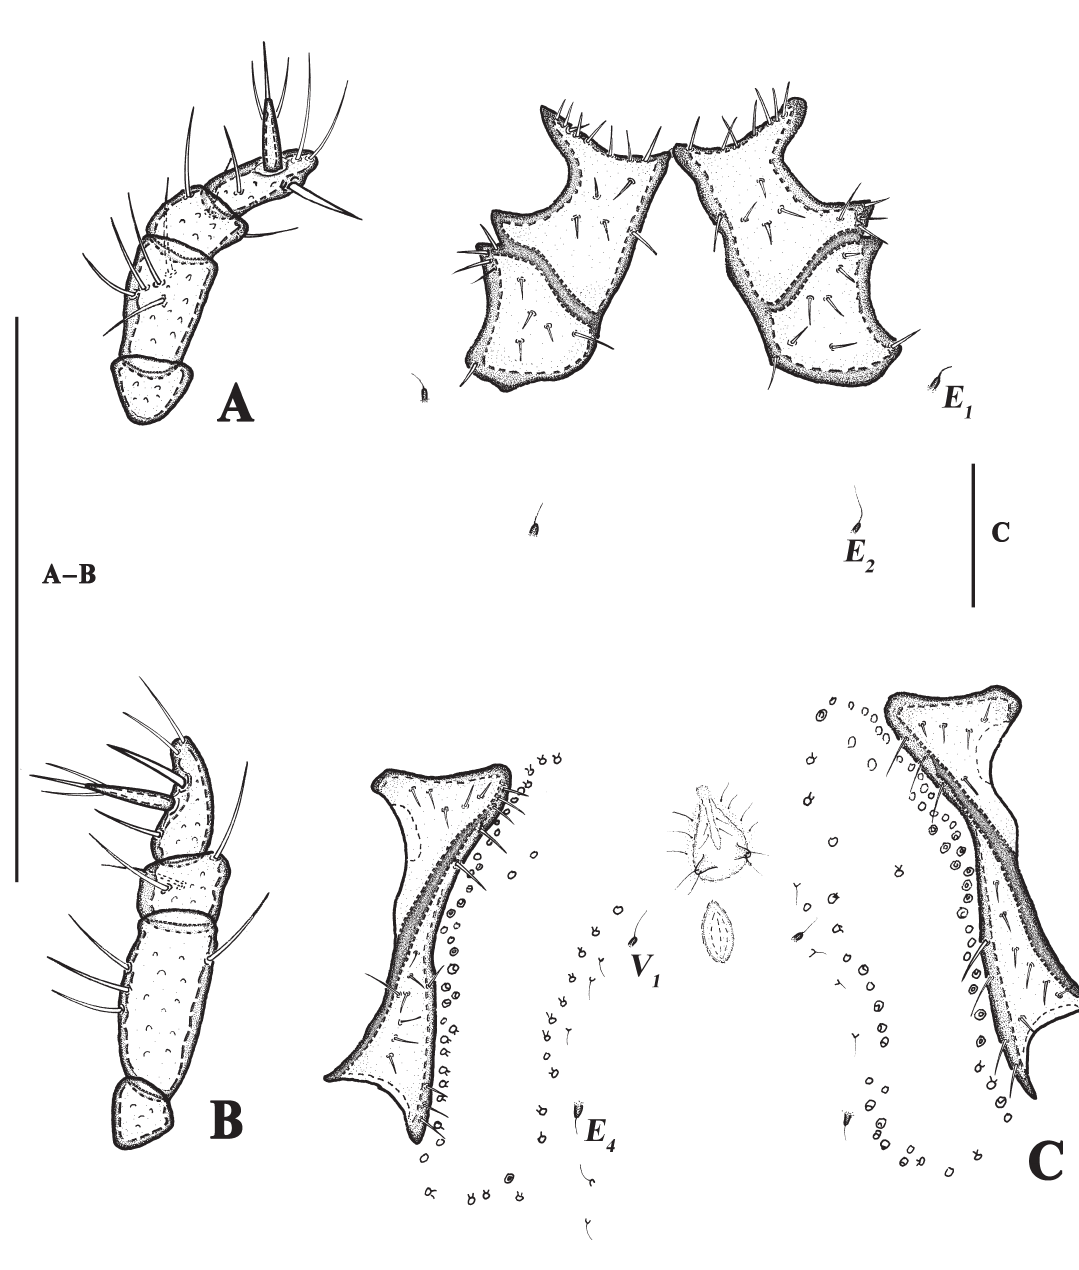
Fig. 8. Pentachares sinensis Li & Guo gen. et sp. nov., holotype, ♀ (GUGC GD-LI-20190801). A . Palp, ventral view. B . Palp, lateral view. C . Idiosoma, ventral view. Scale bars = 200